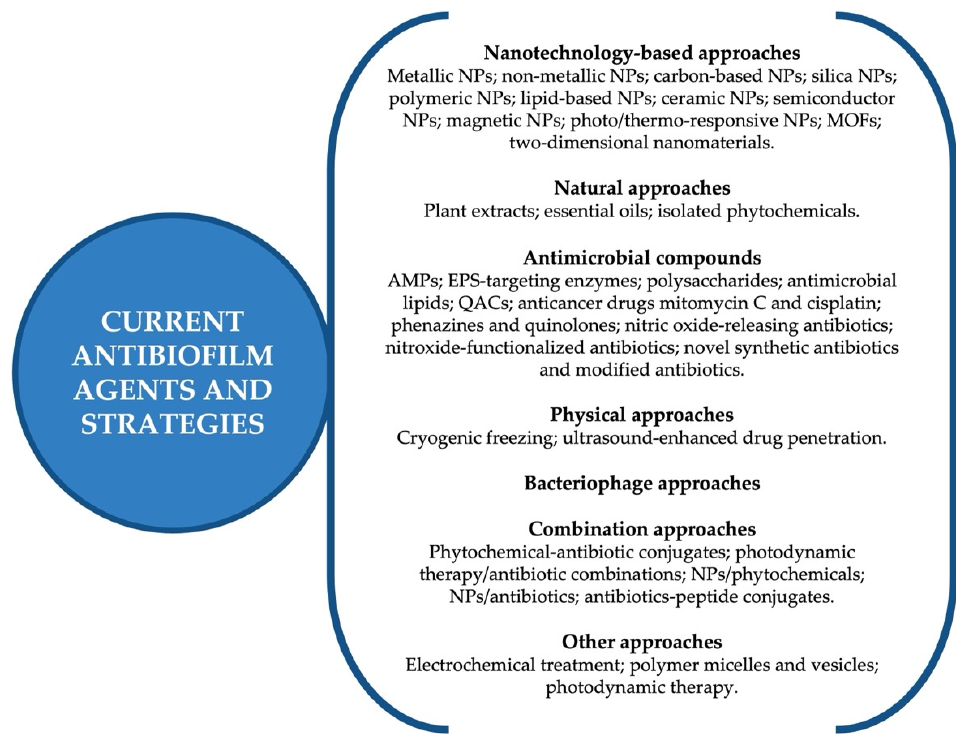
Figure 4. Antibiofilm agents and strategic approaches that are currently being explored and implemented in attempts to fight biofilms in SSIs.